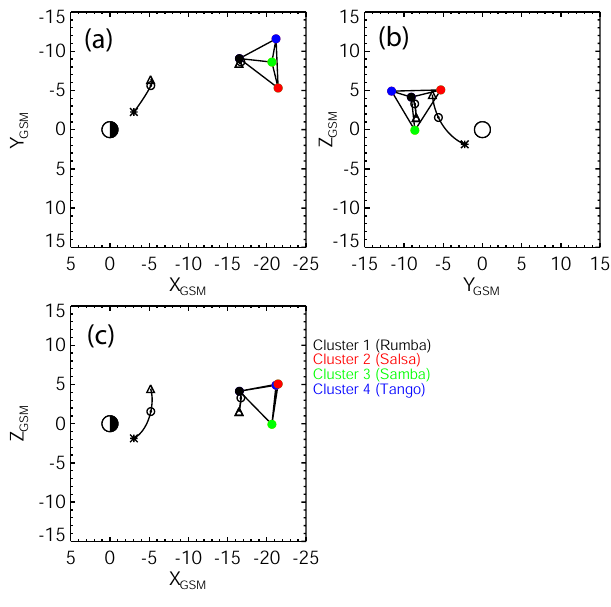
Fig. 1. Plots of the Cluster and Polar orbital positions between 06:00 and 12:00UT in the (a) XY , (b) YZ and (c) XZ in GSM co- ordinates. The Cluster tetrahedron at 06:00UT is magnified by a factor of 20. Cluster 1 (Rumba, black circle) is plotted at the cor- rect location. The locations of Cluster 1 and Polar at 09:00 and 12:00UT are shown by open circles and triangles